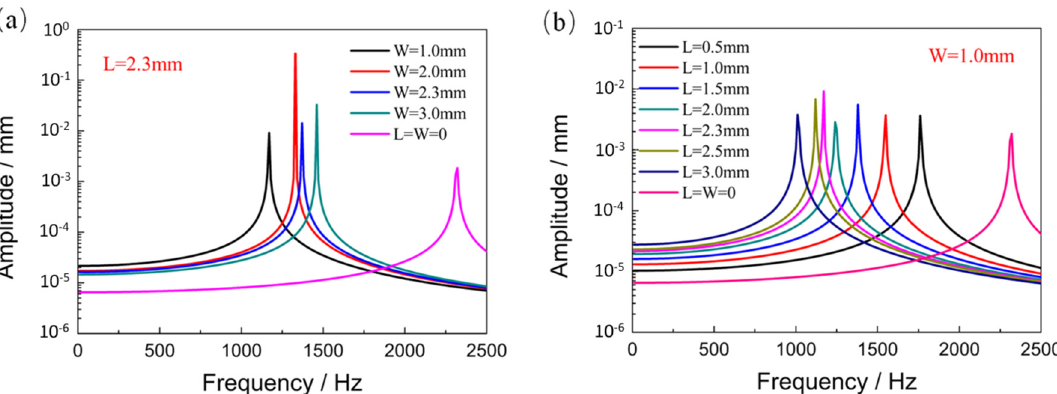
Figure 2. Frequency dependences of the displacement at the center of the wheel-shaped glass diaphragms with different beam widths and lengths obtained with FDTD simulation (( a ) with a fixed beam length of L = 2.3 mm; ( b ) with a fixed beam width of W = 1.0 mm).